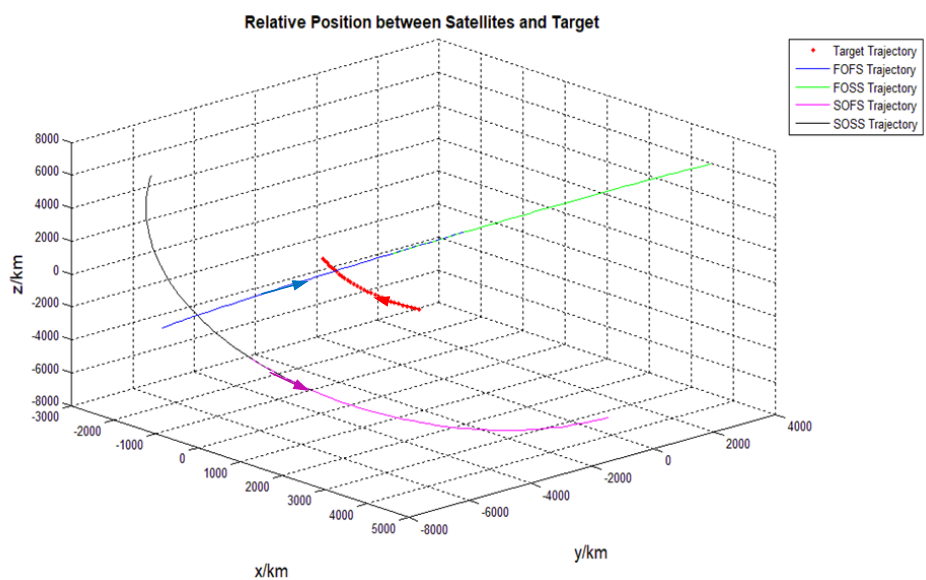
Figure 15. Selection of orbit planes and satellites for target2.